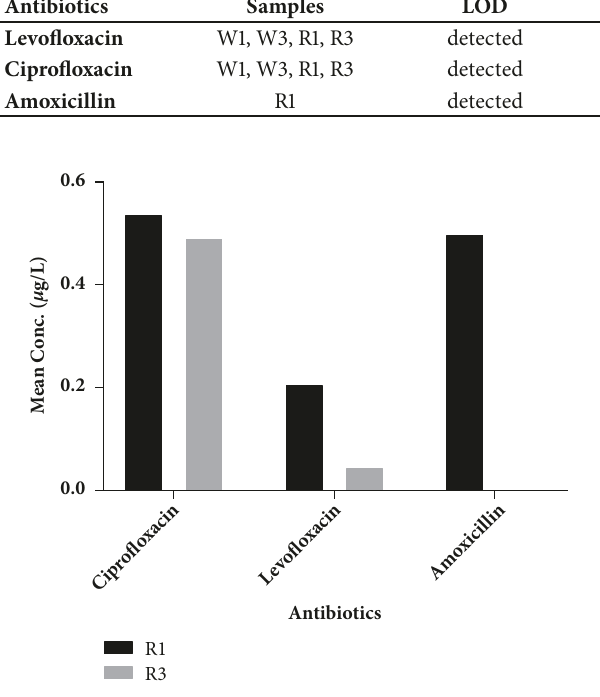
Figure 3: Concentration of antibiotics in water samples at the Al-Rasheed plant. The mean value of antibiotics (ciprofloxacin, levofloxacin, and amoxicillin) in the raw and finished water in Al- Rasheed plant was illustrated where black columns refer to the concentration of antibiotics that were present in raw water (R1) and the gray columns refer to levels in the finished water (R3). The black arrow represents the undetectable amoxicillin in the finished water